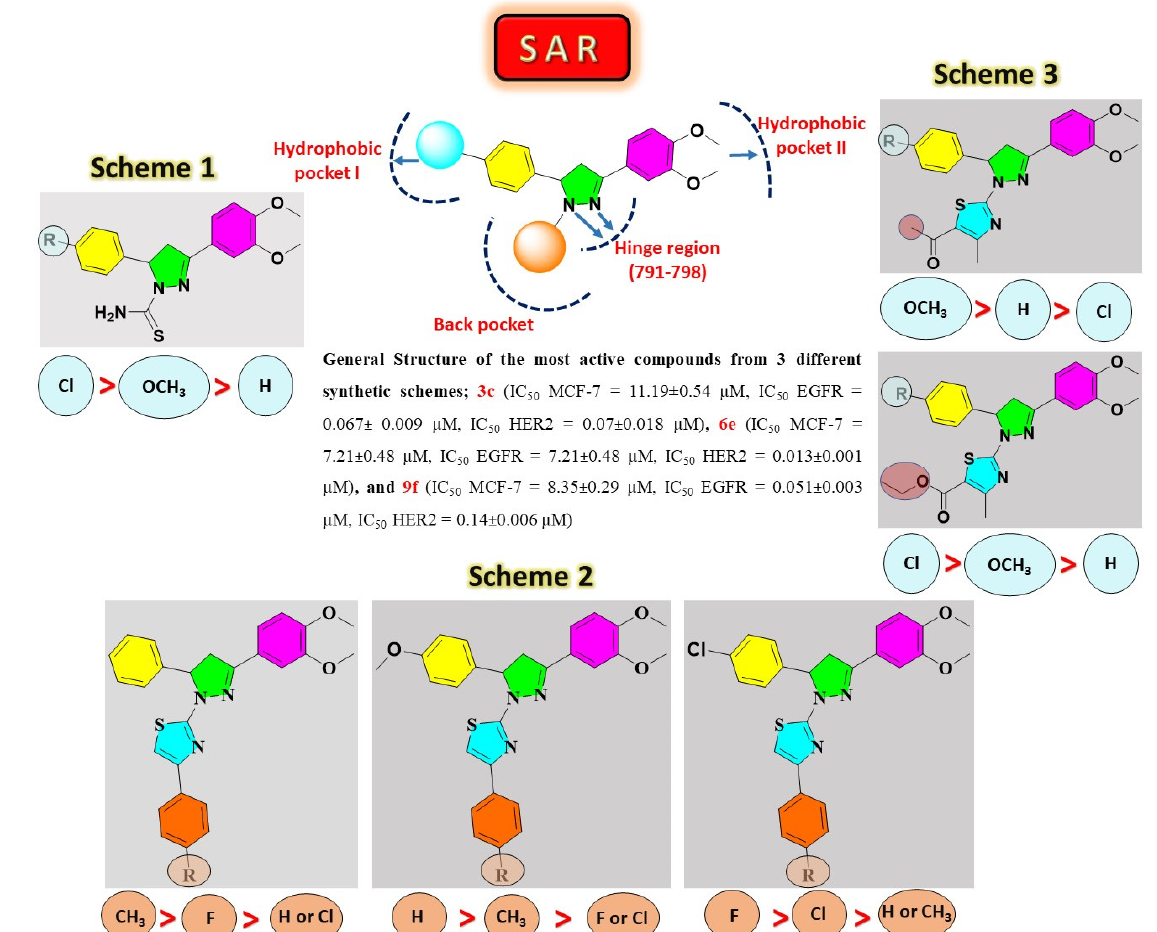
Figure 12. SAR of the newly synthesized compounds 3a-c (Scheme 1), 6a-l (Scheme 2) and 9a-f (Scheme 3). (Scheme